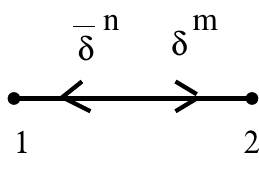
G ( z 1 ; z 2 ), (ii) @ z 1